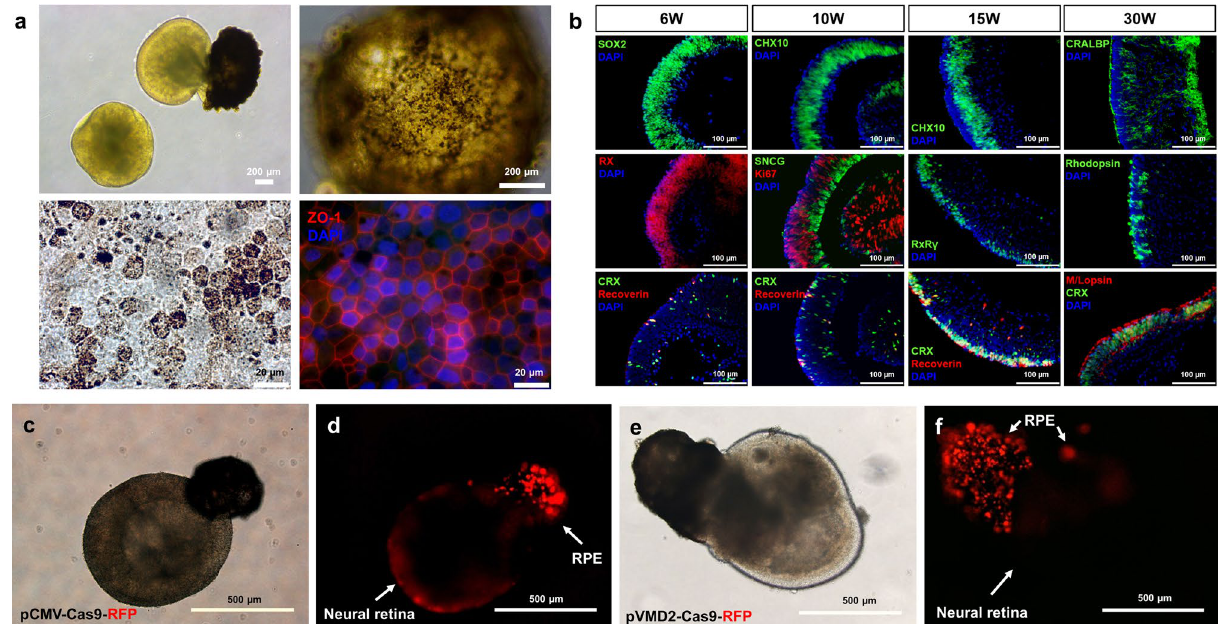
Figure 3. Expression patterns of pCMV-SpCas9-RFP and pVMD2-SpCas9-RFP in human retinal organoids. ( a ) RPE characteristics of pigmentation and hexagonality were confirmed in a 3D sphere and 2D monolayer status ( b ) Retinal organoids express various retinal markers being appropriate to normal developmental stages. A bright-field image and fluorescent image of the human retinal organoid are displayed in pairs ( c , d ; e , f ). ( c , d ) The pCMV vector expressed RFP both in the RPE and neural retina; ( e , f ) whereas the pVMD2 vector expressed RFP only in RPE [ c , e = bright-field image; d , f = fluorescent image]. Each protein marks specific structure or cell types as follows: ZO-1: Tight junction; SOX2: Neural progenitor cell; RX: Retinal progenitor cell; CRX: Photoreceptor progenitor cell; Recoverin: Photoreceptor precursor cell; CHX10: Neural retinal progenitor cell;